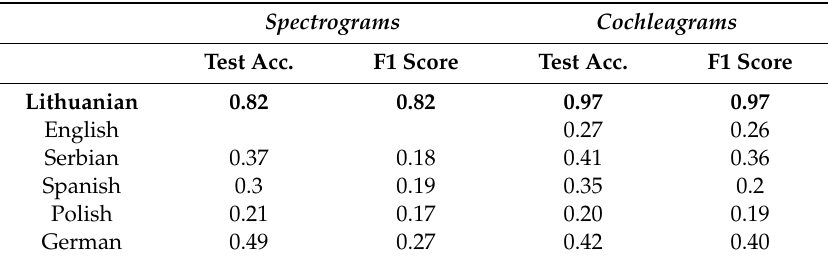
Table 4. Classification test results for spectrograms and cochleagrams: Lithuanian dataset is used for training. The datasets that were used in the training process are highlighted in bold font.